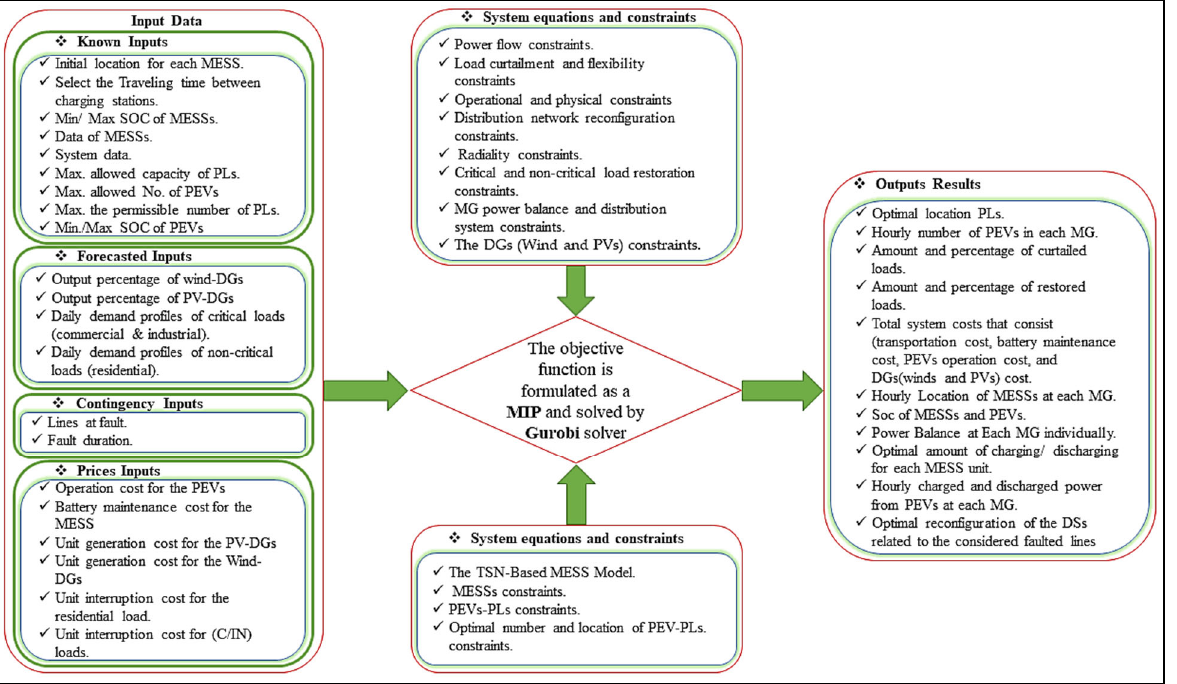
Figure 4. Conceptual framework of the projected operation problem.